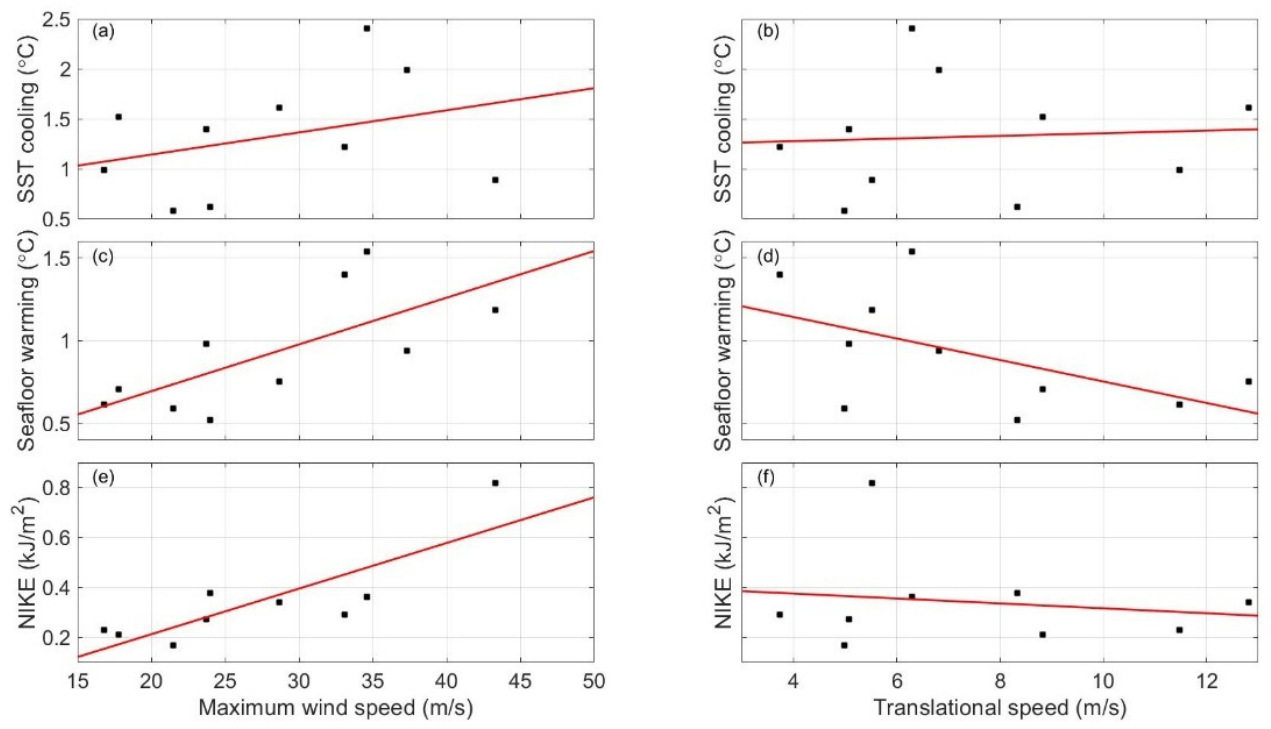
Figure 9. Scatter plots of the ( a , b ) SST cooling, ( c , d ) seafloor warming, and ( e , f ) NIKE versus ( a , c , e ) the maximum wind speed and ( b , d , f ) translation speed. Note that the results corresponding to typhoons Tembin and Bolaven are not shown, because they are too close in time (Table 1) to separate their individual influence on the SST cooling, seafloor warming, and NIKE. The red line in each subfigure denotes the linear fitting result. Note that because the NIKE caused by typhoon Neoguri is extremely high, it is not shown in ( e , f ) and is not considered in the fitting or correlation calculation.